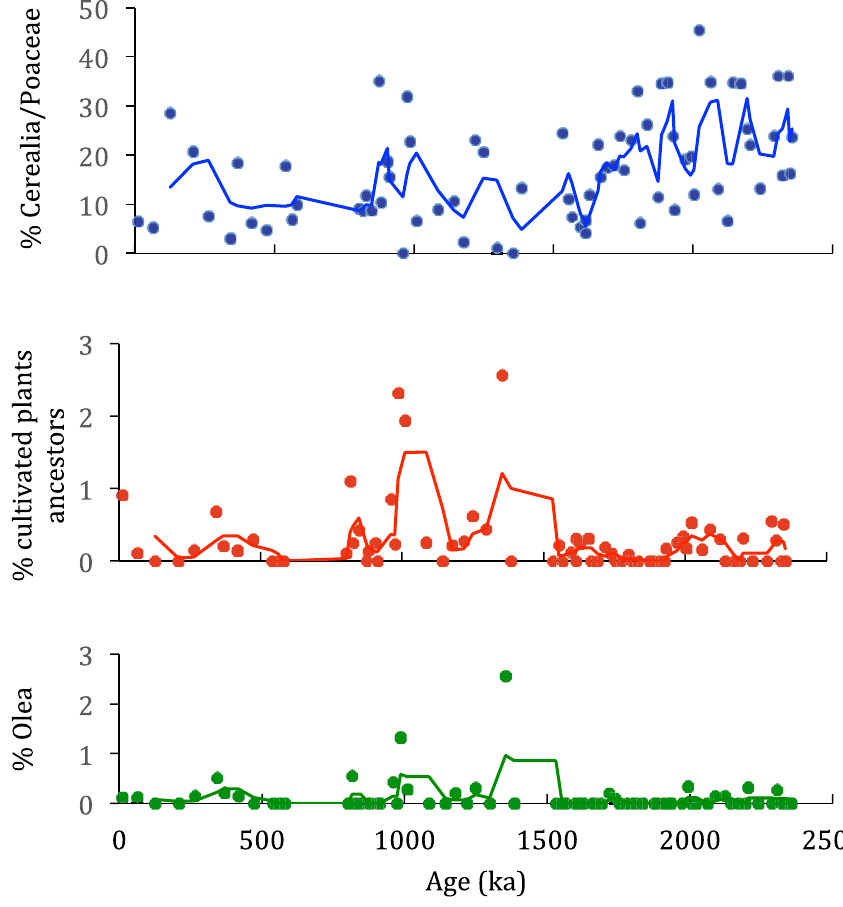
Figure 6. Cerealia/Poaceae ratio in %, % cultivated tree ancestors and % Olea of Acıgöl, core